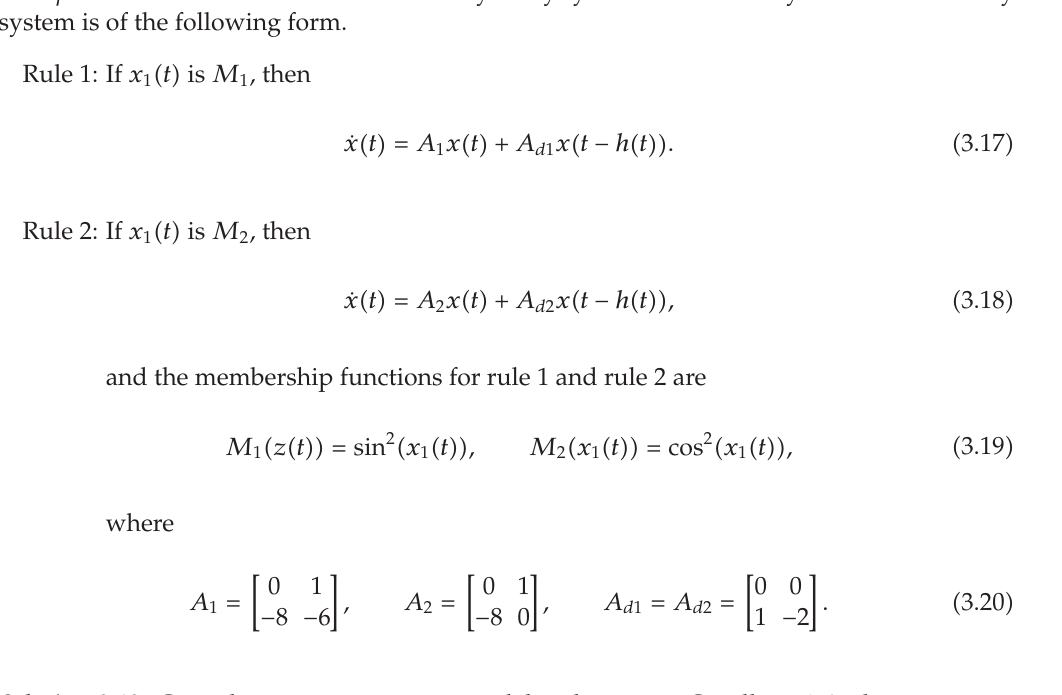
Table 5: MADB h (cid:8) h